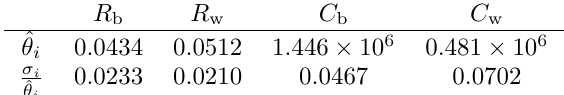
Table 4: Optimal parameters with normalised stand- ard deviations computed with the Hessian method for the R2C2